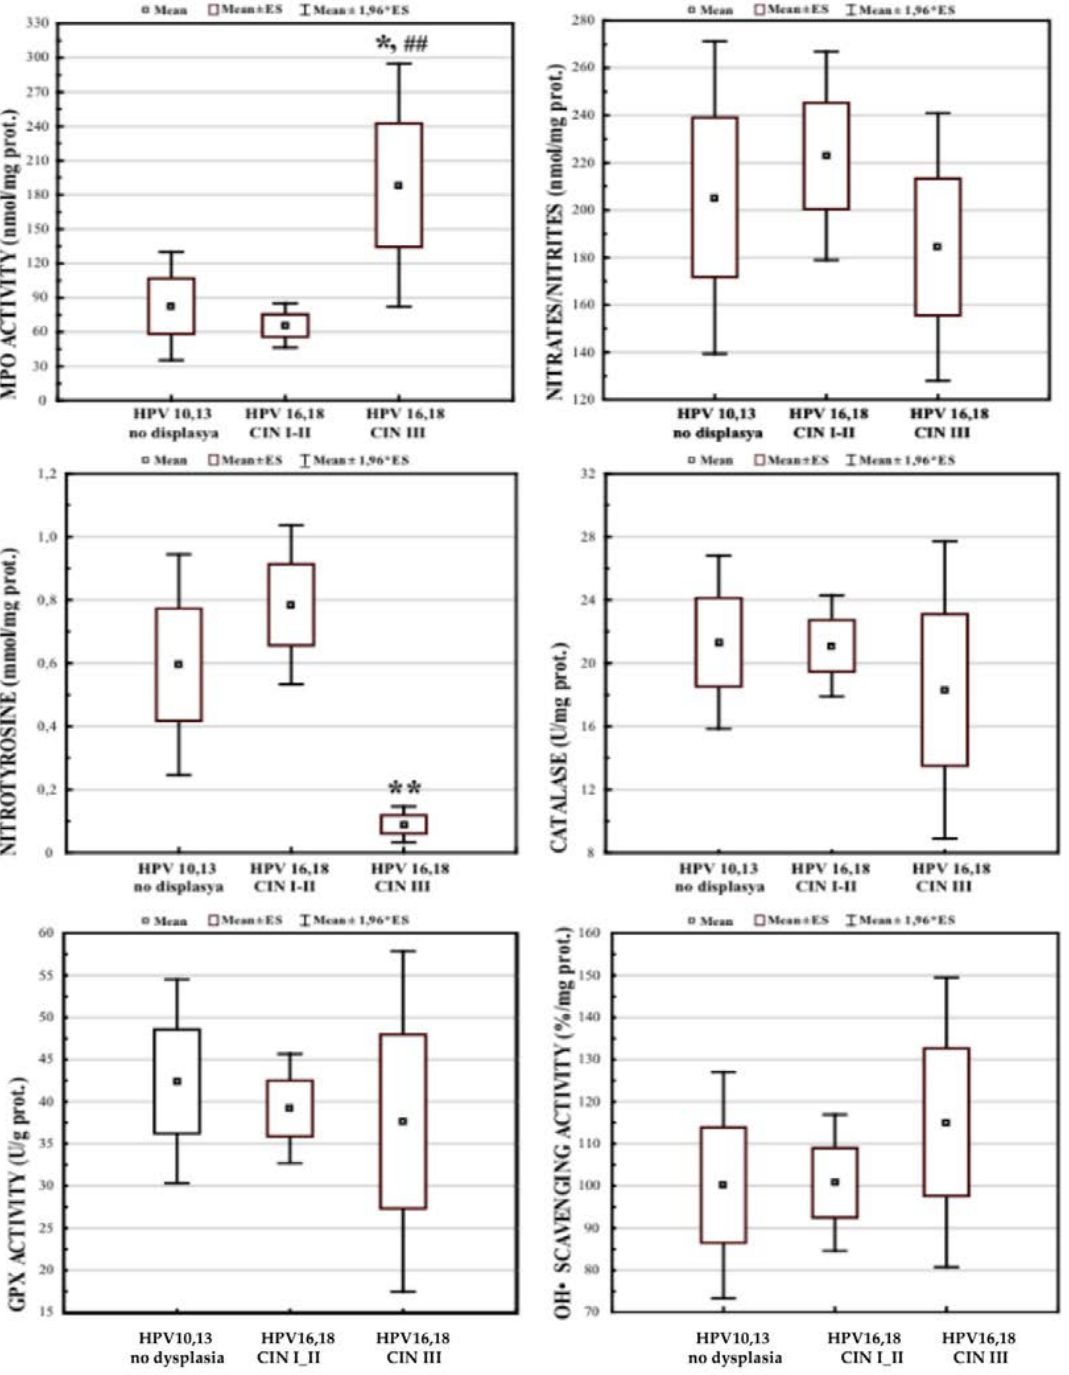
Figure 1. Markers of oxidative stress and antioxidant defence in cervical tissue of females infected with different types of human papillomavirus and at different stages of the disease. Sample size of groups: HPV10/13, n = 42; HPV16/18 CIN I and CIN II, n = 75; HPV16/18 CIN III, n = 45. * p < 0.05 versus HPV10/13 group; ## p < 0.05 versus HPV16/18 CIN I-II group; ** p < 0.01 versus HPV10/13 and HPV16/18 CIN I-II groups. In the CIN I-II group, a strongly significant ( p < 0.01) negative correlation between nitrotyrosine and MPO activity levels was found, as well as a positive significant ( p < 0.05) correlation between nitrate/nitrite levels and nitrotyrosine, as shown in Figure 2